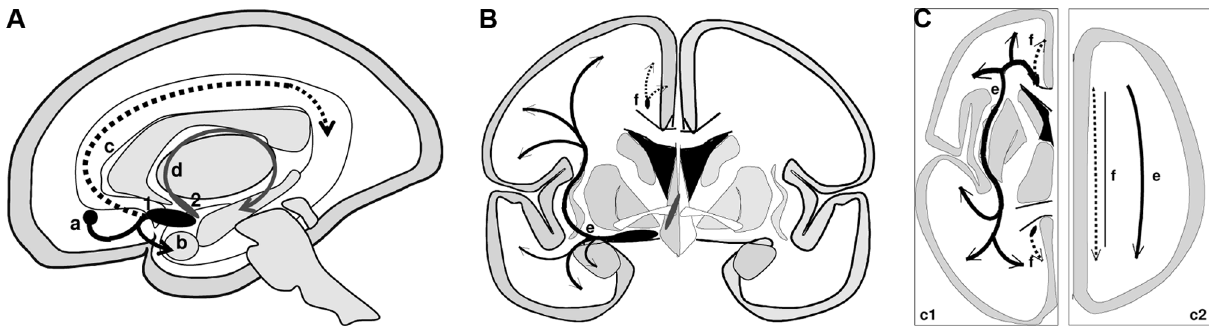
Figure 1. Basal prosencephalon and